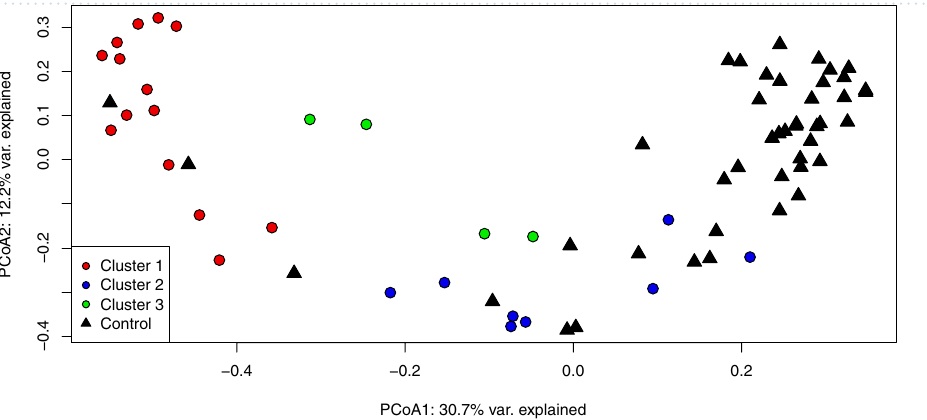
Figure 7. Case resistomes cluster separately and case Cluster 2 is more similar to control samples as shown in a Principal Coordinates Analysis (PCoA) plot of the three case clusters (red, blue, green; circles) compared to the control resistomes (black; triangles) based on Bray–Curtis dissimilarity at the gene level. The first and second coordinate are shown with their respective percentage of explained variance. Case Cluster 1 separates clearly from Clusters 2 and 3 along the first and second coordinate, while case Cluster 2 aligns with a handful of control